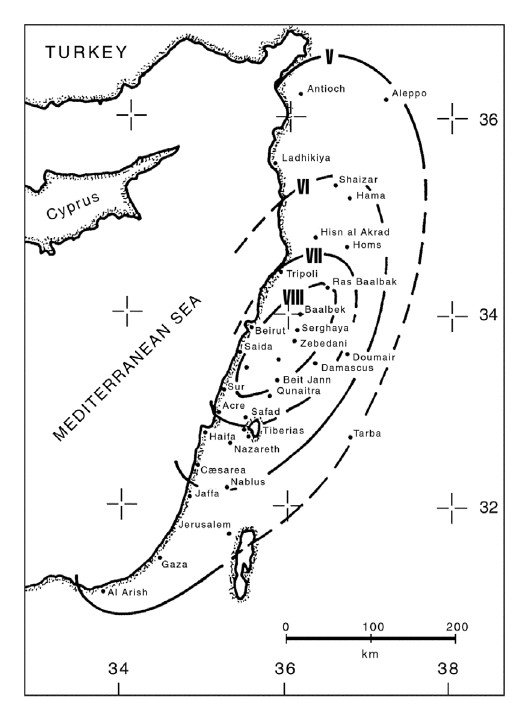
Fig. 20. Map of intensity distribution for November 25, 1759 earthquake (Ambraseys and Barazangi,